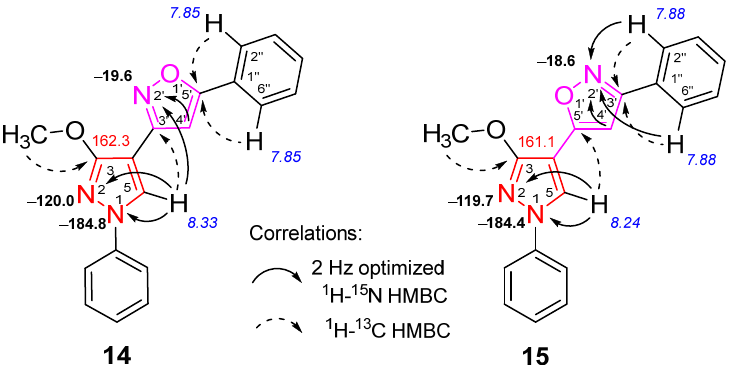
Figure 5. Relevant 1 H- 15 C HMBC and 1 H- 15 C HMBC correlations and 1 H NMR (italics), 13 C NMR and 15 N NMR (bold) chemical shifts of compound 14 , 15 .